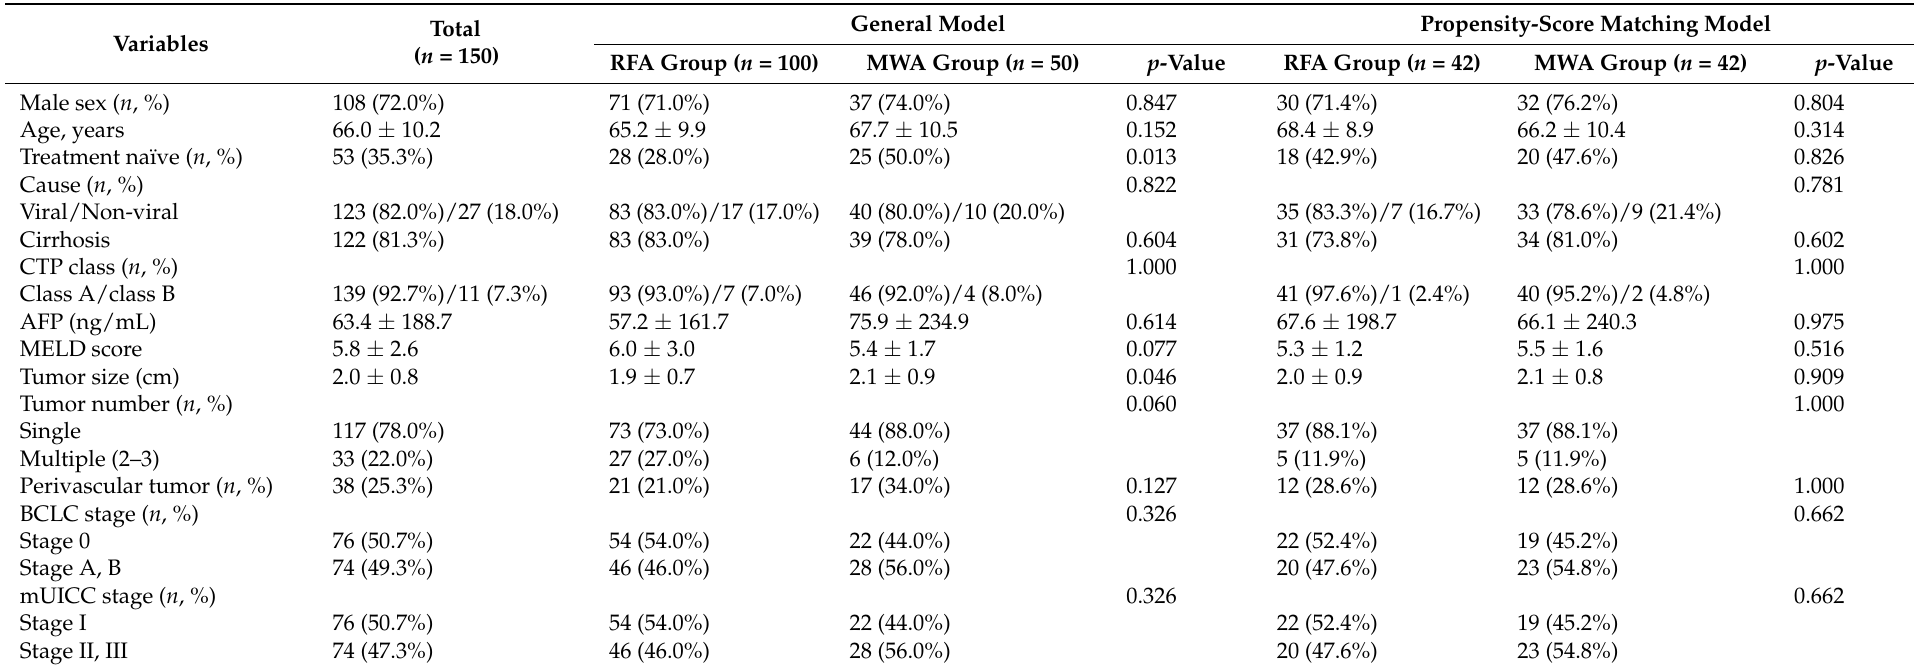
Table 1. Baseline characteristics of the entire population (general and propensity-score matching